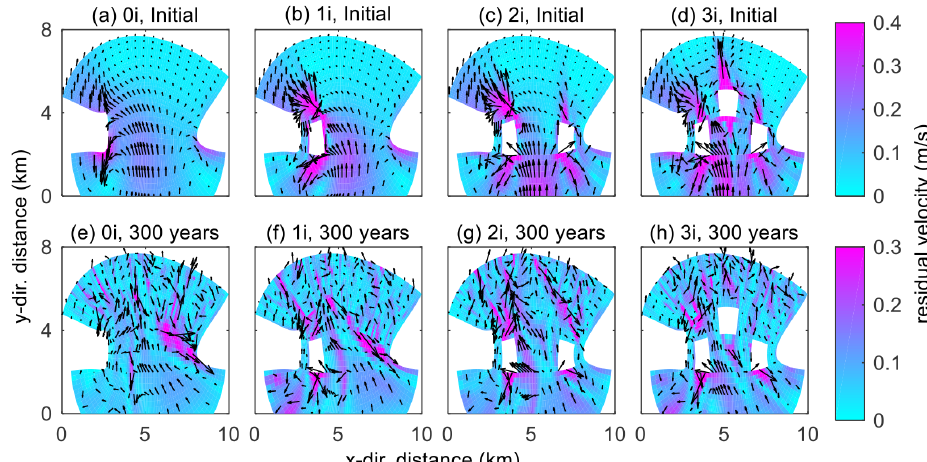
Figure 7. Spatial distribution of the residual current (arrow vectors indicate the direction) near the tidal inlet of four different scenarios: panels (a) – (d) represent scenarios without an island (“0i”), one island (“1i”), two islands (“2i”) and three islands (“3i”) at the beginning, respectively; (e) – (h) after 300 years. The white area in the plot represents the mouth islands, and the background colour represents the magnitude of residual